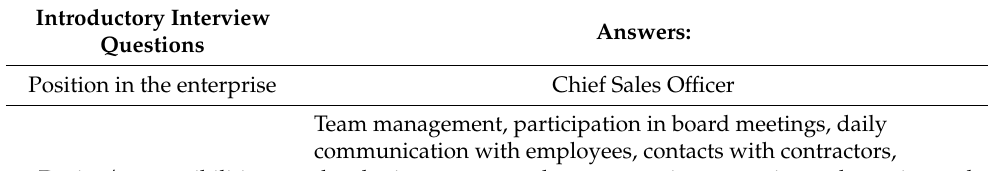
Table 6. Results of the IDI (individual in-depth interview) with the manager of the Hager Polo Ltd. Energy